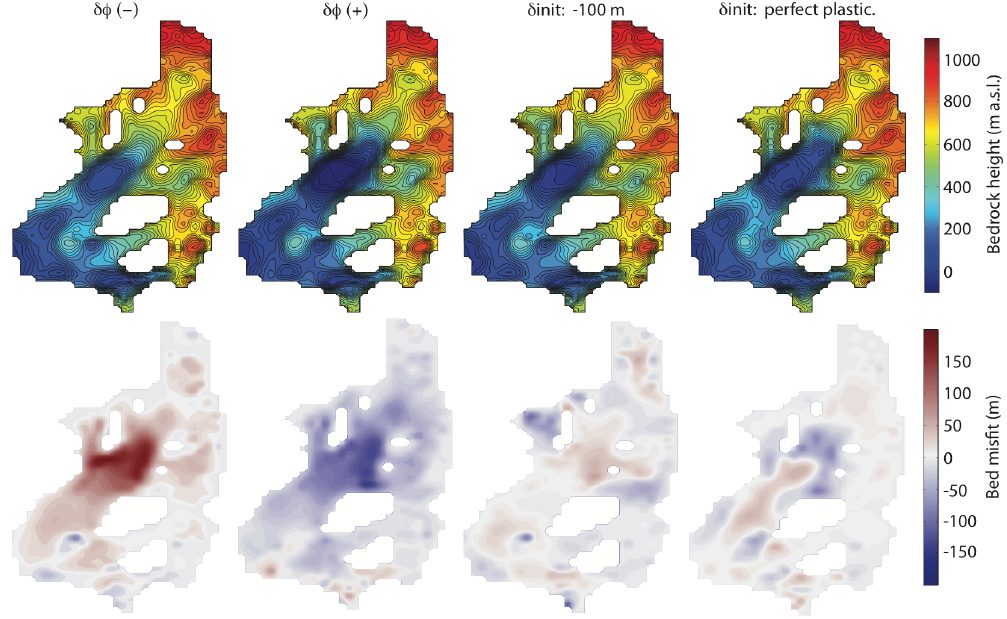
Fig. 11. Final recovered basal topography (1st row) and the corresponding bed discrepancy (2nd row) with regard to the φ = 13 ◦ experiment with a negative perturbation of the material till strength ( δφ( − ) , 1st column), a positive till strength perturbation ( δφ( + ) , 2nd column), a uniformly lowered initial bed (3rd column) and an initial bed from perfect plasticity (4th